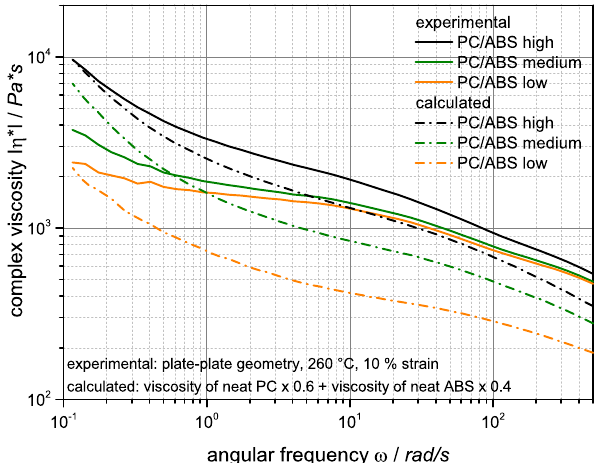
Figure 5. Shear rate dependence of the complex viscosities measured (solid lines) at 260 °C for the investigated PC/ABS blends containing SAN of different molecular weight (high, medium, and low). The dotted lines show a comparison with the weight-averaged viscosities of the blends components PC and the respective ABS, calculated as 0.6 × η PC + 0.4 × η ABS .